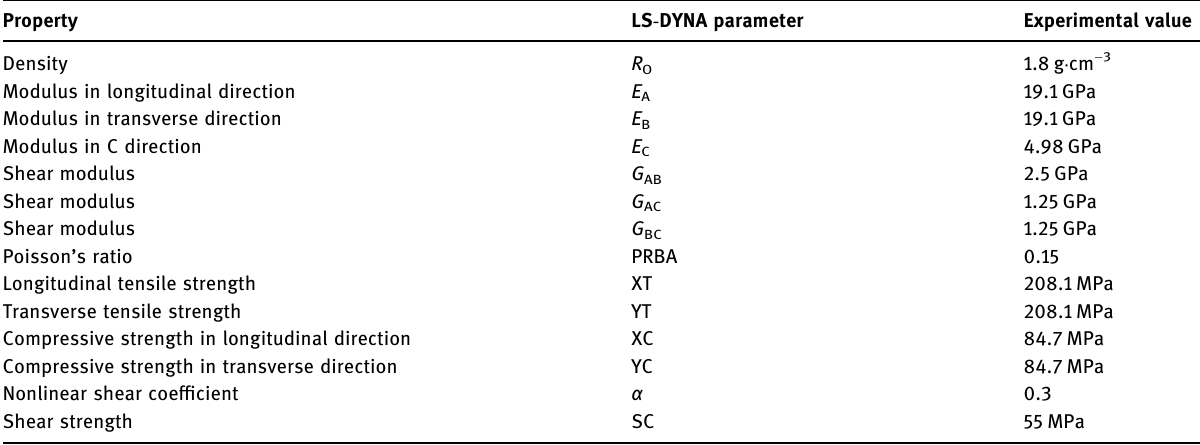
Table 6: The parameters of GFRP